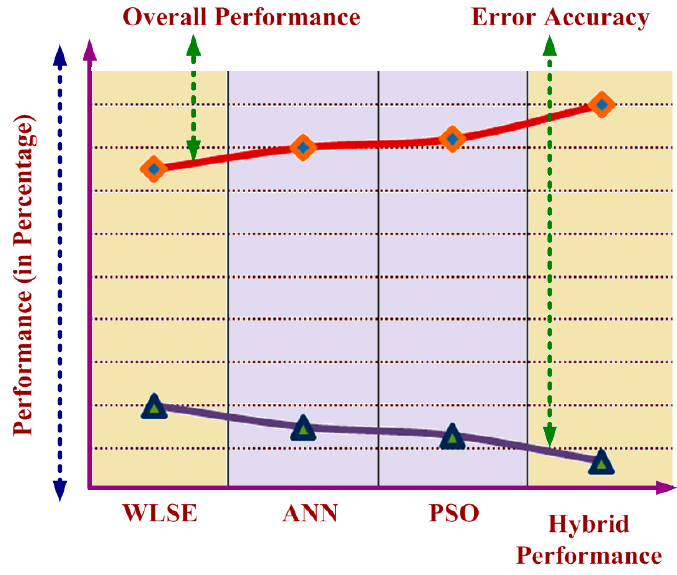
Figure 3. Performance Analysis of Algorithms.